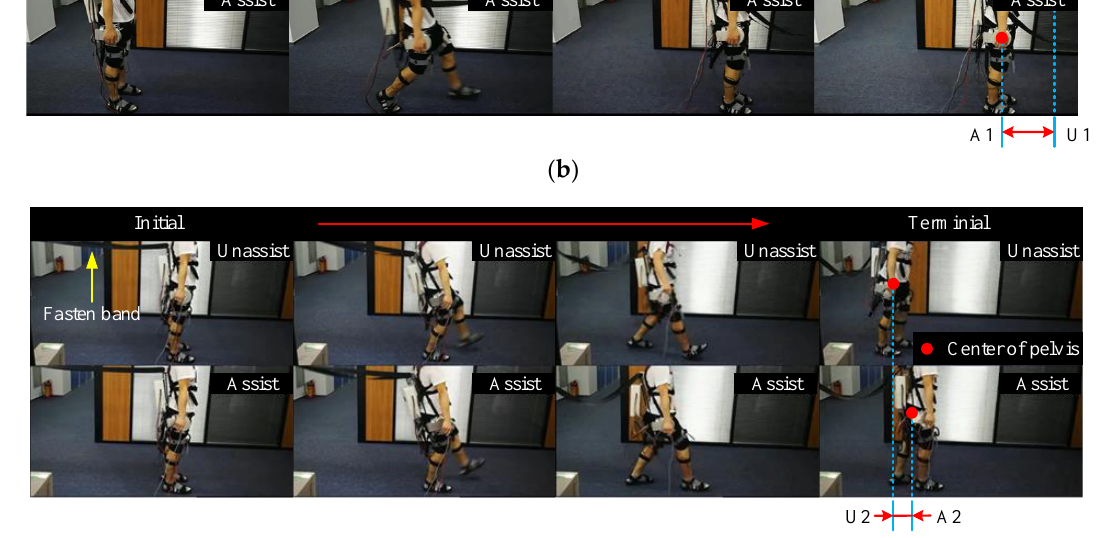
Figure 14. The degree of single step balance.